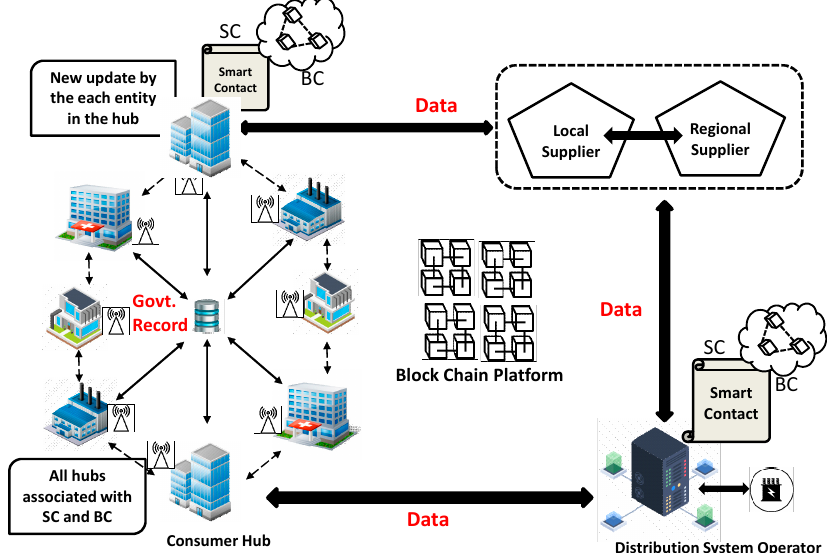
Figure 1. Traditional Blockchain based transaction model for deregulated market .